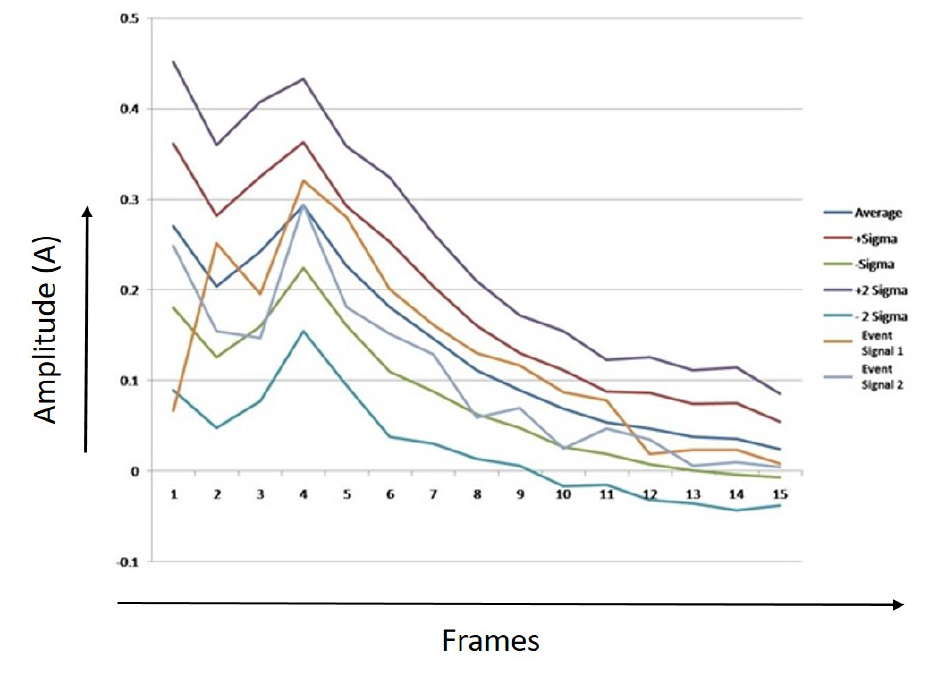
Figure 22. Threshold boundaries for human.